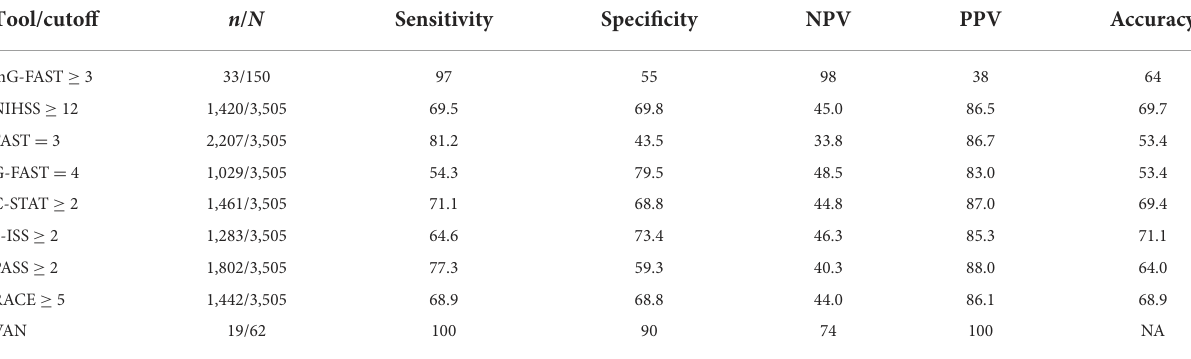
TABLE 5 Statistical parameters of most commonly used stroke